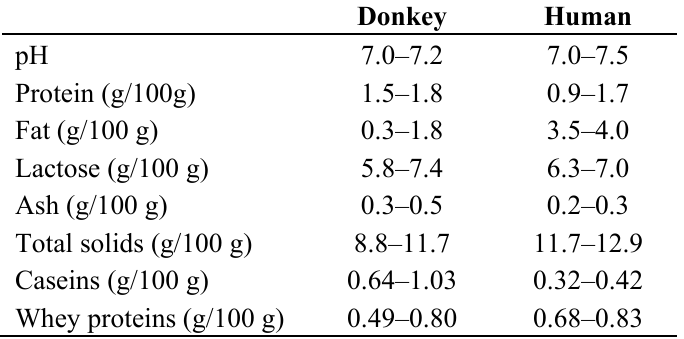
Table 1. Comparison of chemical composition and physical properties of donkey and human milk  24 